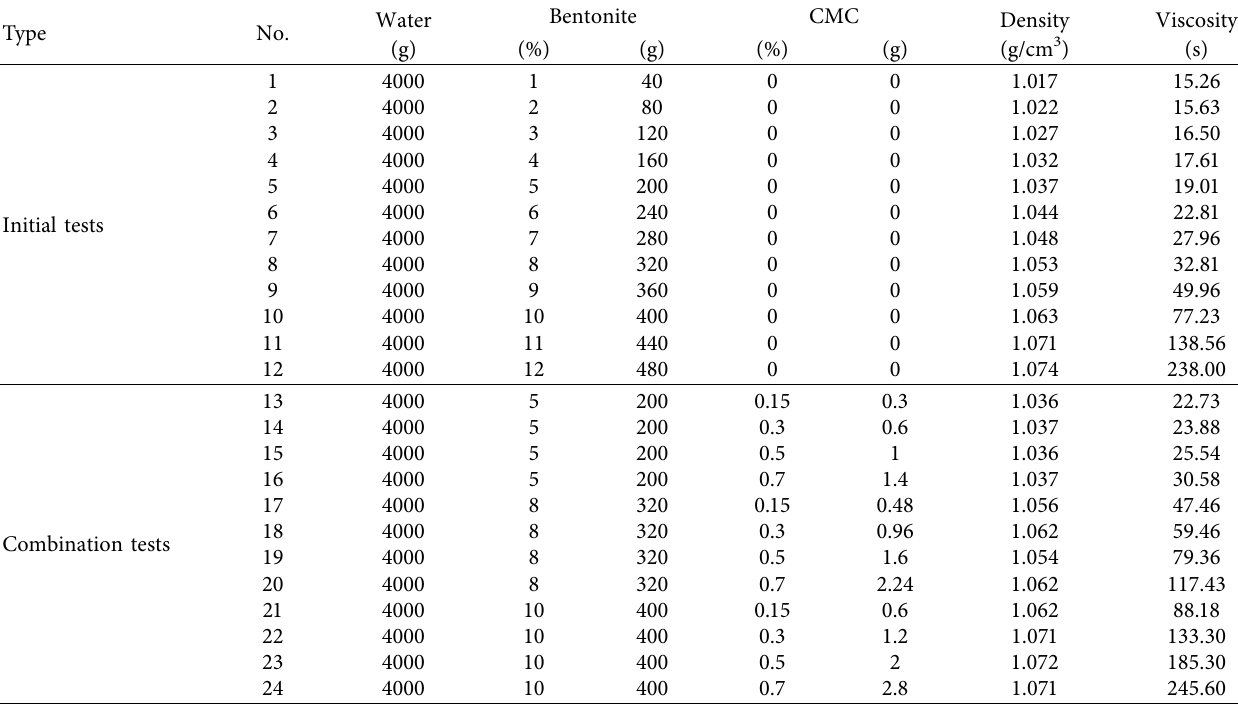
Table 4: Results of slurry optimization experiment.